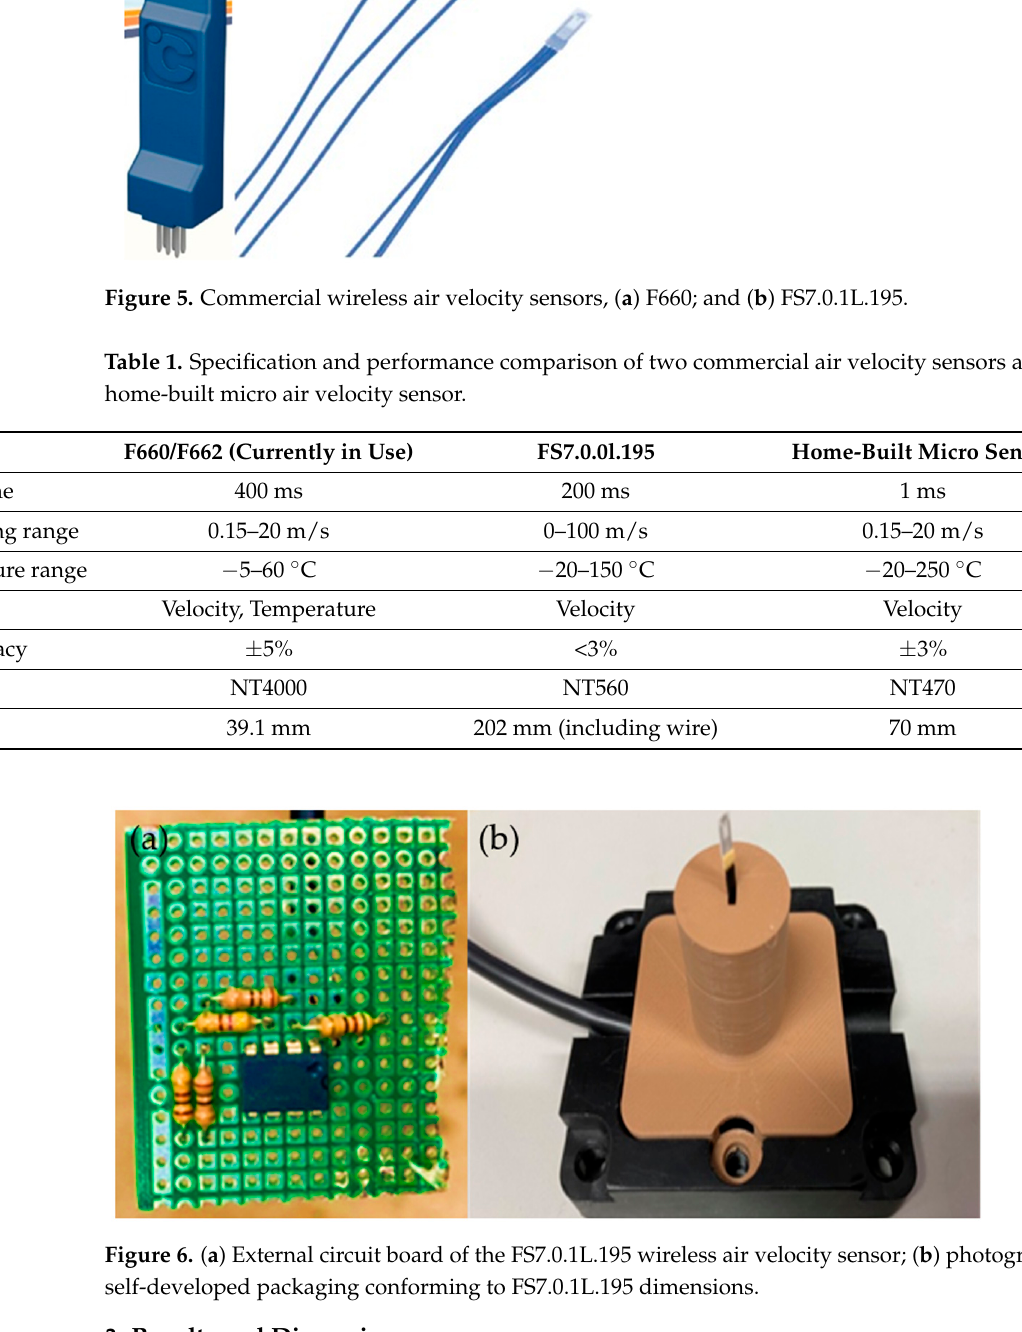
Figure 7. Calibration of home ‐ built flexible micro air velocity sensor at different temperatures.